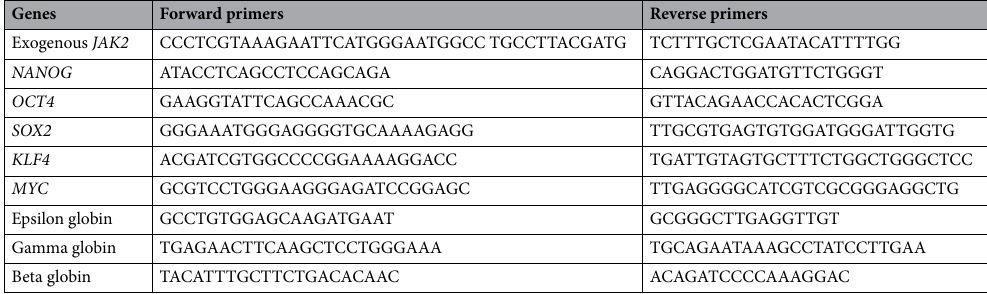
Table 1. The primer sets for exogenous JAK2 , pluripotency testing of stem cells and hemoglobin